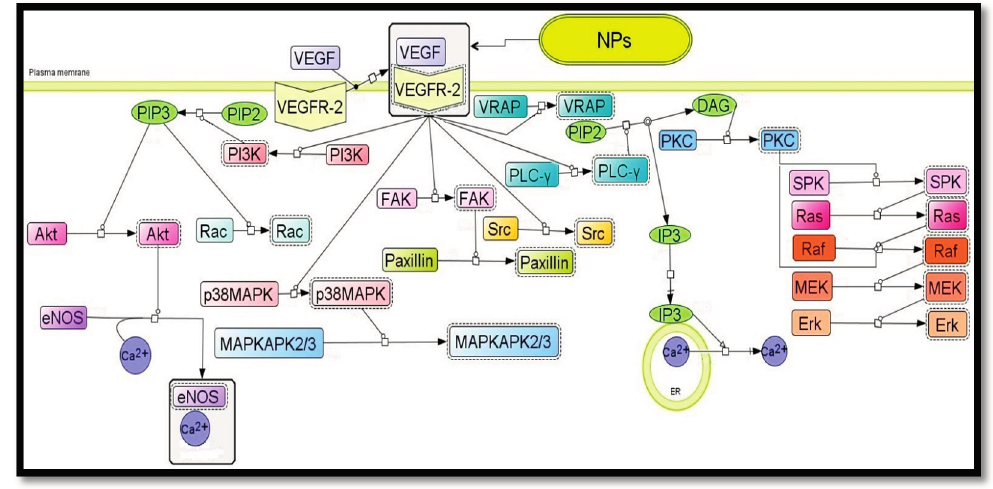
Figure 2. The proposed signaling pathways of nanoparticles anti-angiogenesis